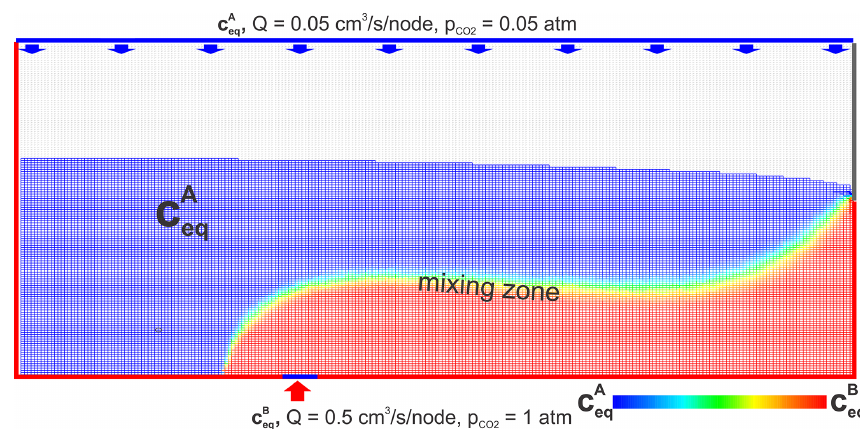
Figure 2. Visualization of the mixing zone. Two types of waters, one with calcium equilibrium concentration c B eq and the other with equilib- rium concentration c b eq , invade the aquifer. Flow domains red and blue are separated by a water divide. There dispersive mixing takes place, and the equilibrium concentration of the mixed solution is between the values c B eq and c A eq (see Fig. 3). This is depicted by a colour code with red for the highest concentration c B eq decreasing down through the optical spectrum to dark blue for concentration c A eq . This way the colours indicate the degree of mixing. The green region hosts one-by-one